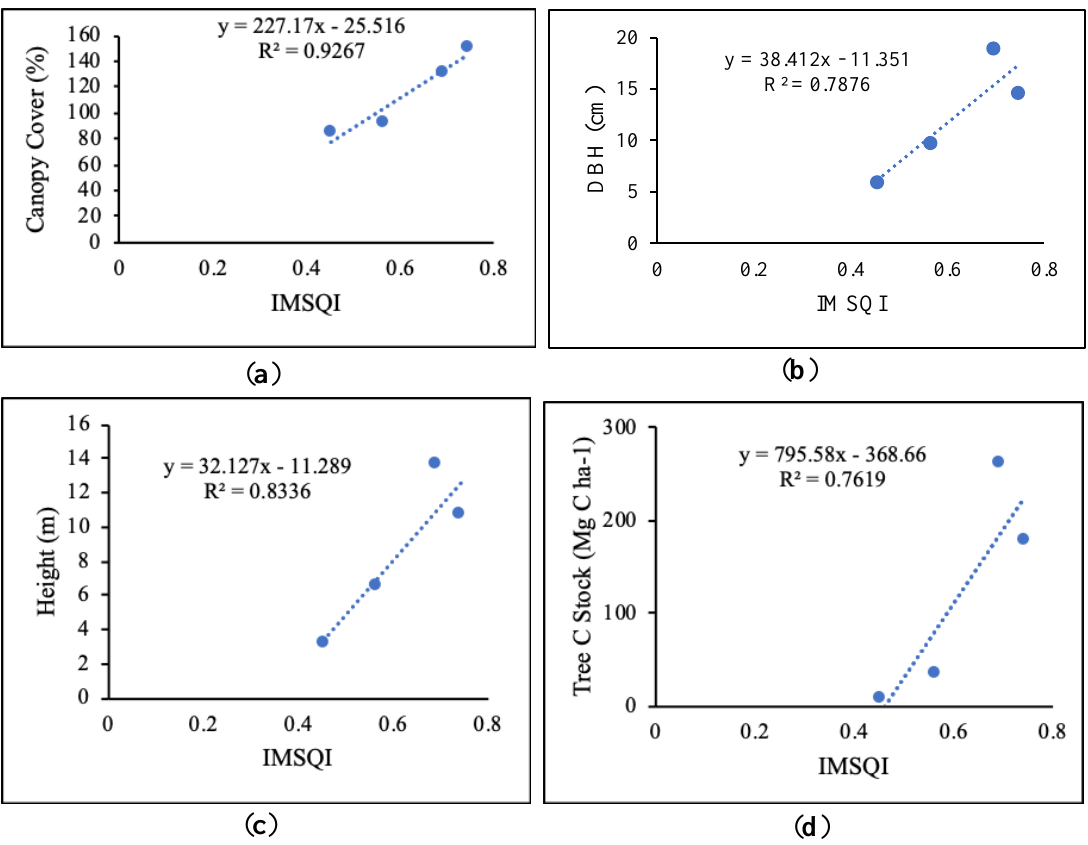
Figure 4. Correlation between mine soil quality index and plant growth parameters ( a ) canopy cover ( b ) diameter at breast height (DBH) ( c ) tree height ( d ) tree carbon stock.